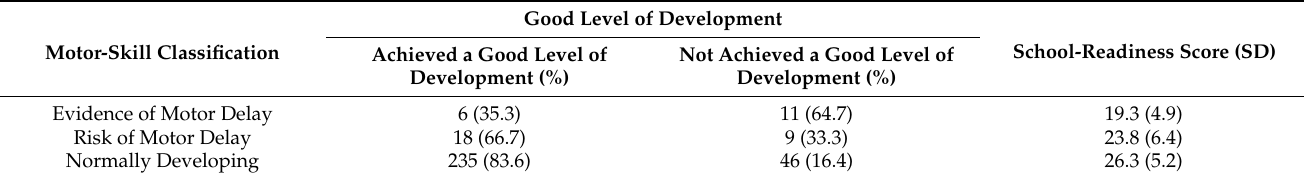
Table 2. Frequency of children achieving a good level of development and mean school-readiness score for each motor-skill classification.